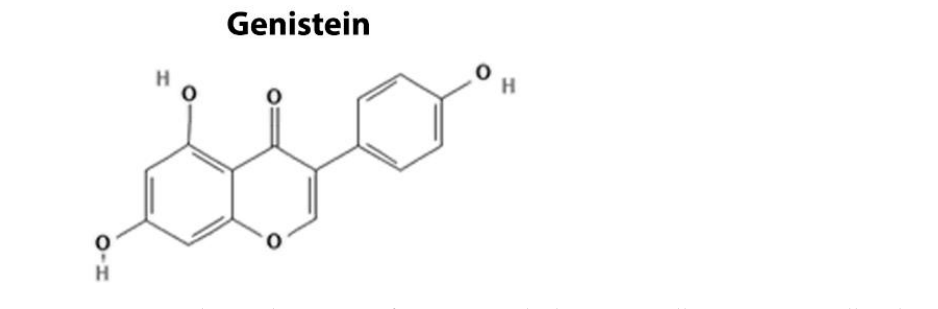
Figure 3. Chemical structure of Genistein, which is a naturally occurring small molecule that targets extracellular components such as Wnt antagonists in the Wnt/β-catenin signaling pathway. Table 1. Naturally occurring small molecules and their respective molecular targets and mechanisms of inhibition of the Wnt/β-catenin signaling pathway.